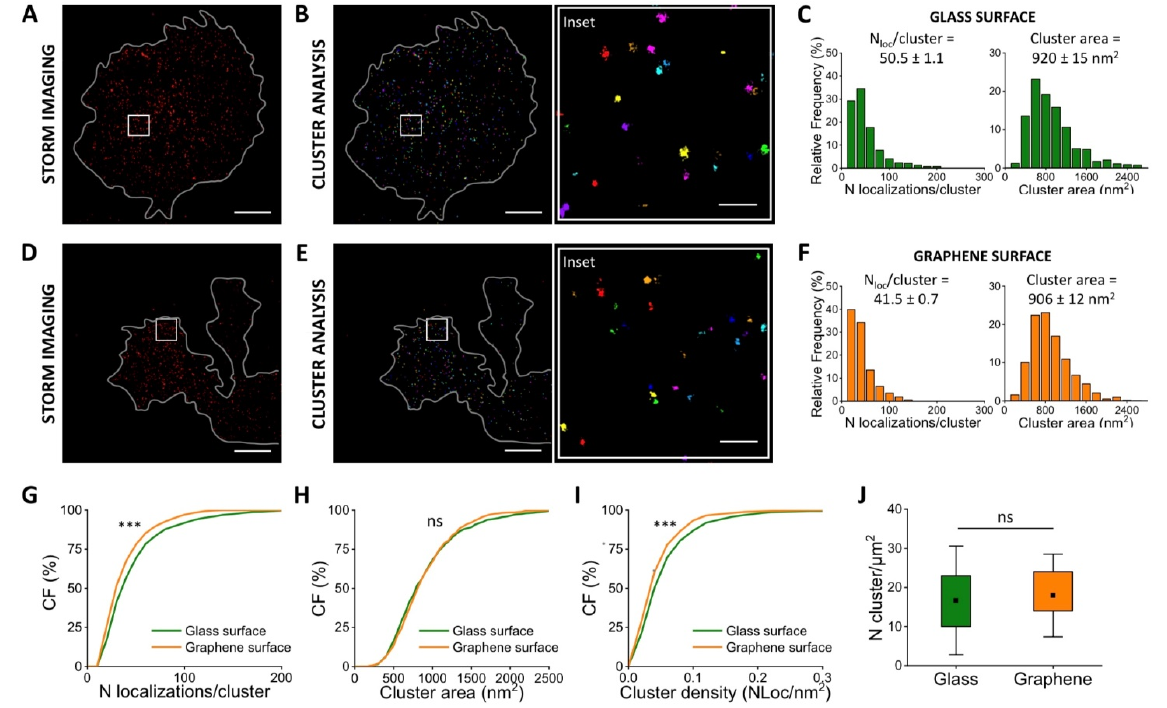
Figure 3. Quantitative super-resolution imaging of vinculin in neurons (DIV1). STORM imaging ( A ) and cluster analysis ( B ) of vinculin immuno-stained with A405/A647 in neurons seeded on glass. Frequency distribution of localizations/cluster and cluster area measured in cells seeded on glass ( C ). STORM imaging ( D ) and clustering ( E ) of vinculin immuno-stained with A405/A647 in neurons seeded on SLG. Frequency distribution of localizations and cluster area in cells grown on SLG ( F ). The cumulative distribution shows a 22% decrease in the average number of localized events ( G ) for vinculin-imaged in cells adhered on SLG (41.5 ± 0.7 N loc / cluster) and on glass (50.5 ± 1.1 N loc / cluster). Cumulative distribution of the cluster area ( H ) doesn’t show significant differences in cells adhered on SLG (906 ± 12 nm 2 ) compared to cells adhered on glass (920 ± 15 nm 2 ). The cumulative distribution shows a 21% decrease in average density ( I ) in cells adhered on SLG (0.053 ± 0.001 N loc /nm 2 ) compared to cells adhered on glass (0.064 ± 0.002 N loc /nm 2 ). The average number of vinculin clusters/area ( J ) for cells on glass (16.6 ± 2.1 N cluster /µm 2 ) and graphene (18.0 ± 1.4 N cluster /µm 2 ): the box shows 25/75th percentile and the whiskers are the standard deviation, T-test statistically non-significant. The total number of analyzed clusters is N glass = 941 and N graphene = 1147 for glass and graphene substrates, respectively, for n > 3 independent experiments. Kolmogorov–Smirnov Statistical test: ns nonsignificant, *** p < 0.001. Scale bar = 5 µm. Scale bar inset = 500 nm.